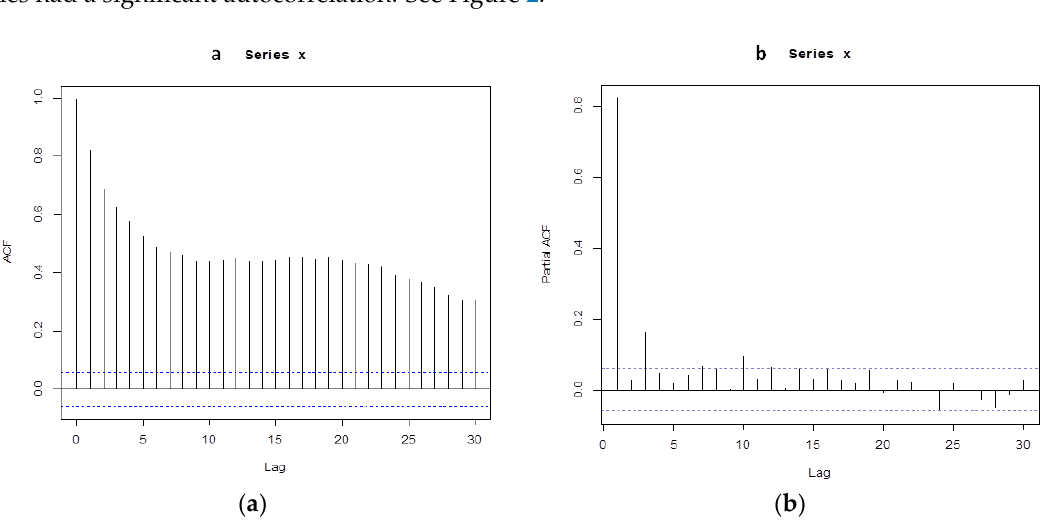
Figure 2. The autocorrelation function and partial autocorrelation function of daily PM 2.5 concentration. ACF = autocorrelation function; Partial ACF = partial autocorrelation function. ( a ) The autocorrelation function of daily PM 2.5 concentration. ( b ) The partial autocorrelation function of daily PM 2.5 concentration.